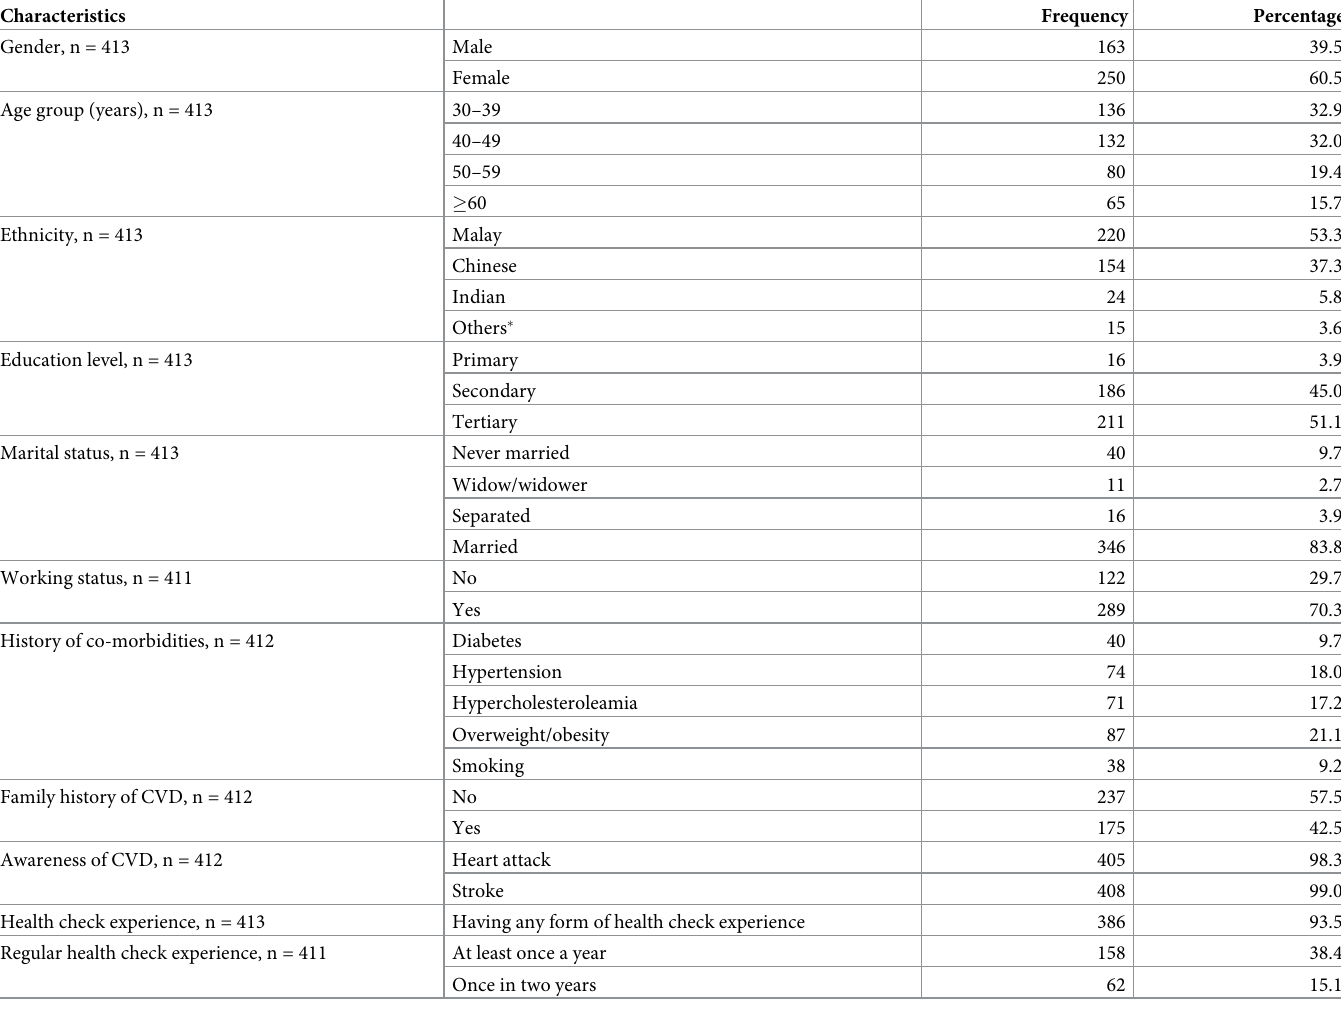
Table 1. Characteristics of participants in survey. Characteristics